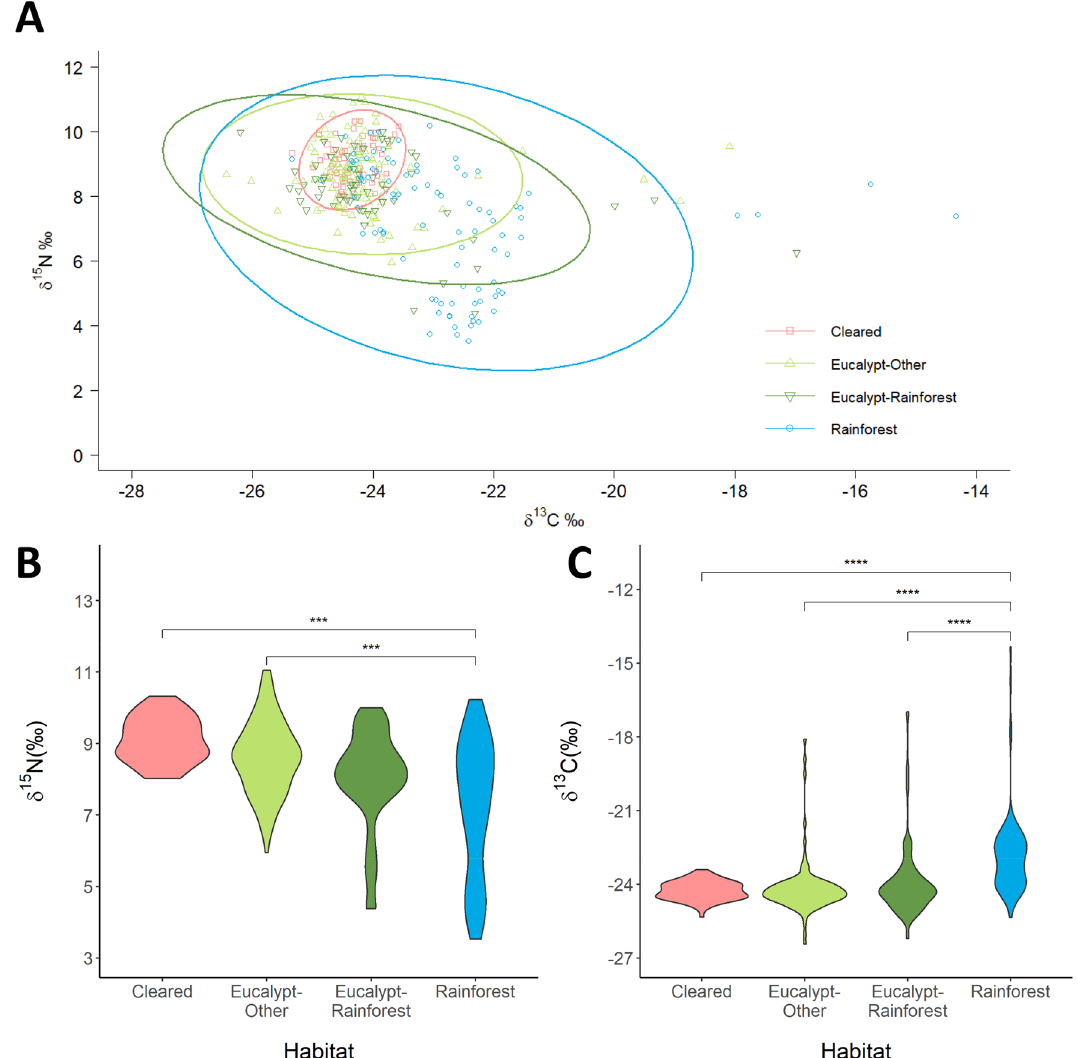
Figure 3. ( A ) Isotopic niches (CI = 0.95) for Tasmanian devils (n = 321 values from 109 individuals) from inhabiting four different habitats: cleared land (n = 19); wet eucalypt forest with other secondary habitat (n = 38); wet eucalypt forest with rainforest secondary habitat (n = 21); and rainforest (n = 31). ( B ) Violin plot of δ 15 N values (‰) for individuals (n = 116) in each habitat (cleared: n = 19; wet eucalypt-other: n = 43; wet eucalypt- rainforest: n = 22; rainforest: n = 32). ( C ) Violin plot of δ 13 C values (‰) for individuals (n = 118) in each habitat (cleared: n = 26; wet eucalypt-other: n = 38; wet eucalypt-rainforest: n = 21; rainforest: n = 33). Asterisks indicate p -values of Tukey post-hoc pairwise comparisons between habitats, where ****≤ 0.0001 and ***≤ 0.001.